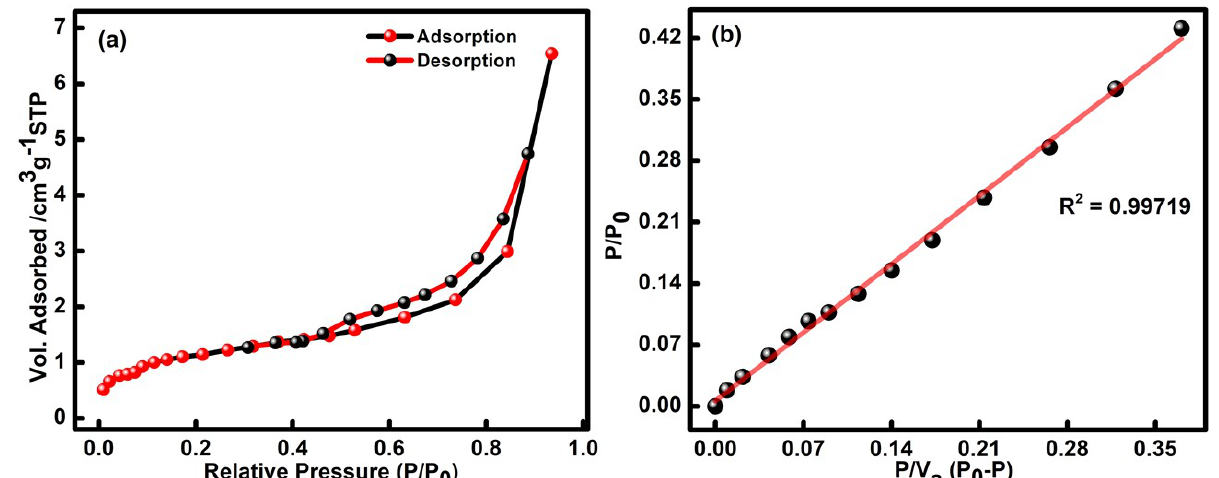
Figure 1. ( a ) Adsorption-desorption isotherm and ( b ) BET plot of developed CQDs. The UV-vis. spectral profile of the formed CQDs has displayed a characteristic ab- sorption band between 300 and 400 nm (Figure 2a). The obtained absorption hump is related to the n- π * and π - π * transition of the C=O and C=C bond of the carbonyl and carboxyl groups on the exterior facade of the CQDs [35]. The synthesized CQDs have a reflected, milky, transparent color under the visible light, and an oceanic blue color was obtained under UV light (inset Figure 2a). The effect of different concentrations of CQDs, ranging from 1.0 mg/mL to 4.0 mg/mL, was also measured using UV-vis spectroscopic studies (Figure 2a). On interpreting the results, it was found that, with an increase in the concentration, three bands at wavelengths of 320 nm, 350 nm and 370 nm were observed,